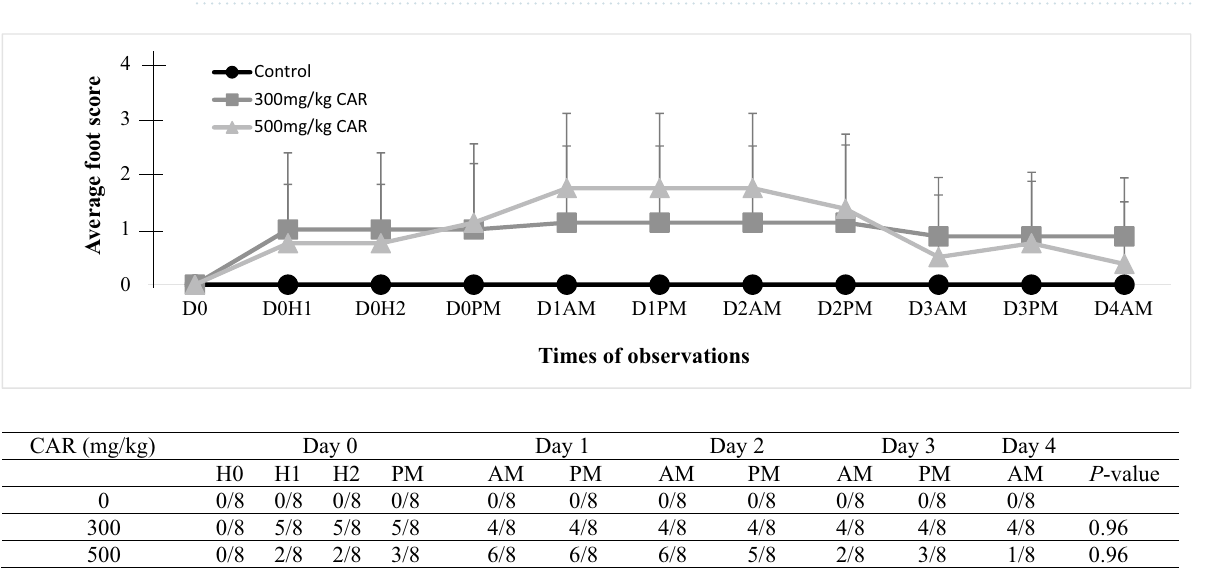
Figure 4. The averaged foot/leg scores (means ± SD; upper panel) and number of mice with scores of > 0 (lower panel) in controls and CAR treated mice. D and H: day and hour post-injection. Scoring system: 0 = normal; 1 = closed digits but walked well; 2 = closed digits, no grip; 3 = closed digits, no grip, dragging leg, foot